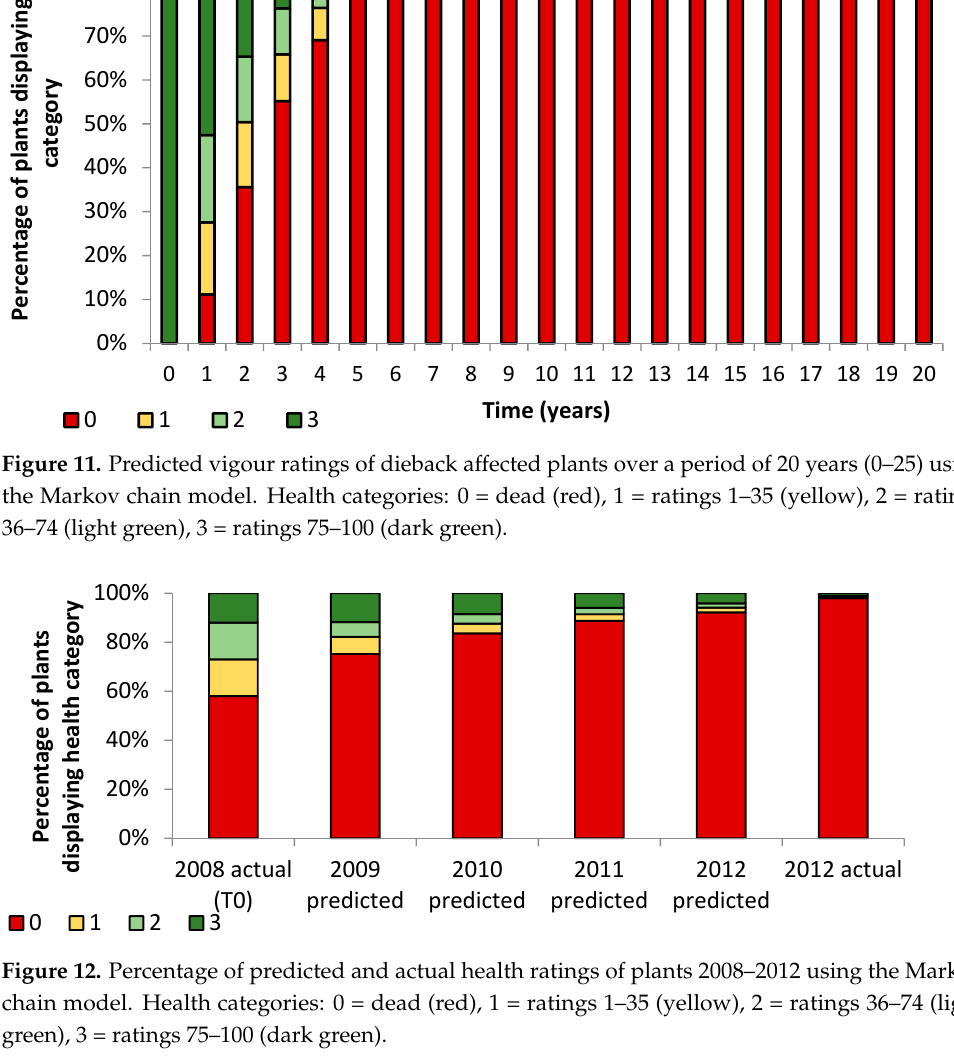
Figure 12. Percentage of predicted and actual health ratings of plants 2008–2012 using the Markov chain model. Health categories: 0 = dead (red), 1 = ratings 1–35 (yellow), 2 = ratings 36–74 (light green), 3 = ratings 75–100 (dark green).